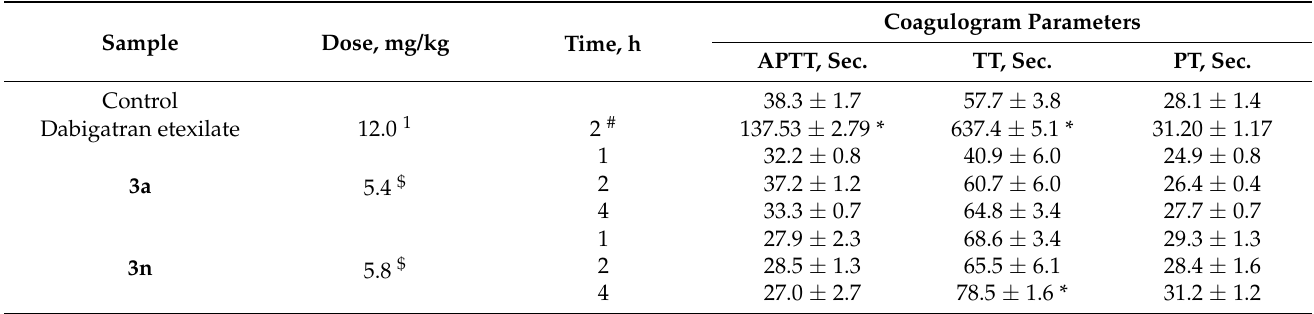
Table 6. Effect of compounds 3a and 3n in equimolar dabigatran etexilate doses on the coagulogram of rats with a single intragastric administration (M ± m, n = 5).